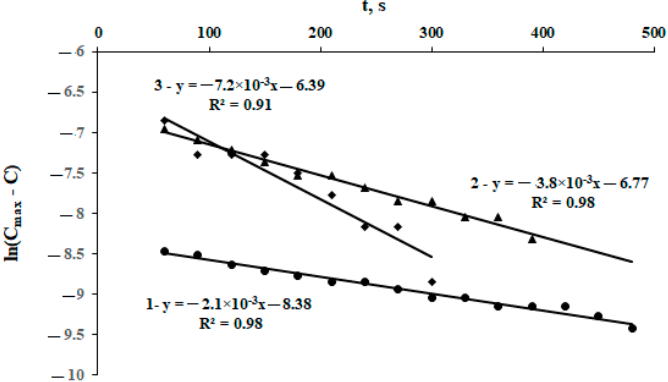
Figure 2. Linear anamorphoses of kinetic curves in coordinates “ln ( C max − C ) vs. t”, obtained for the polymerization of methylene blue (0.005 M) at the following temperatures: 1–298 K; 2–308 K; 3–318 K.